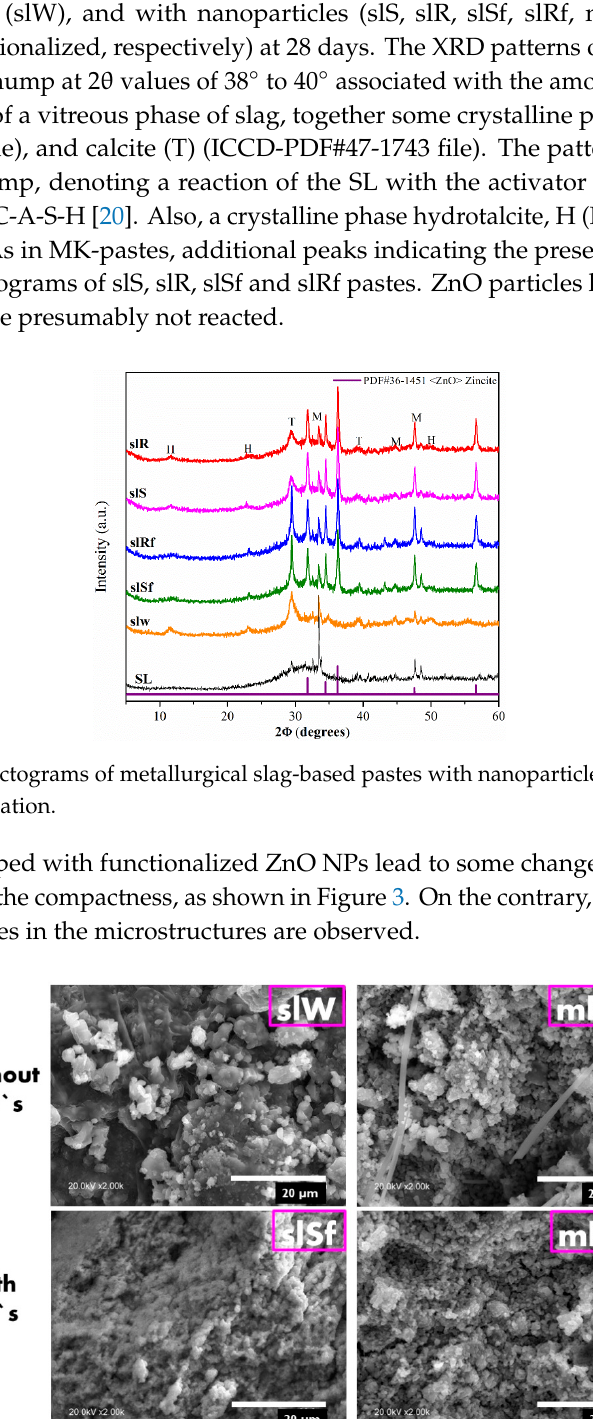
Figure 1. XRD diffractograms of metakaolin-based pastes with nanoparticles functionalized and without functionalization.